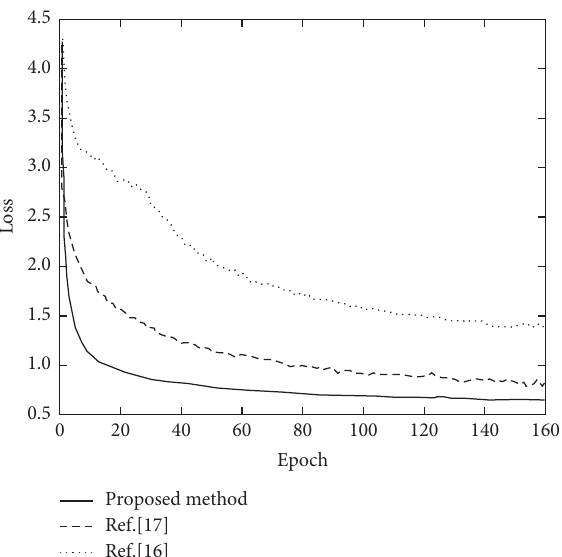
Figure 7: Loss curve of diferent methods in training stage.